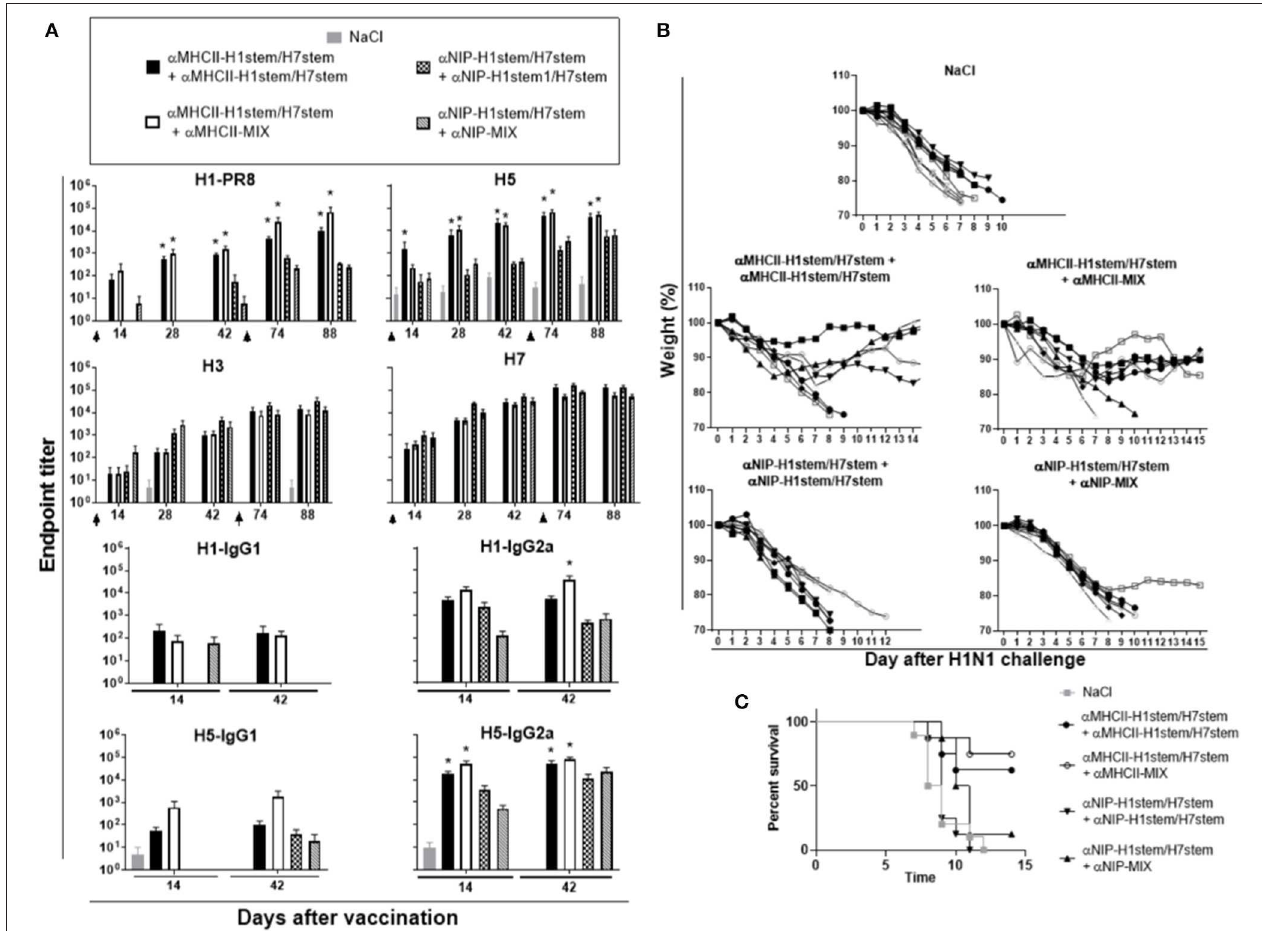
FIGURE 6 | Protection after boost with HA stem domain of MHCII-targeted vaccine mixture. (A) F1 of BALB/c and knock-in 9,114 gH mice ( n = 8 mice/group) were immunized twice, as indicated by arrows, and sera analyzed for development of IgG responses against recombinant HA from PR8 (H1N1), A/Hong Kong/1/1968 (H3N2), A/Hong Kong/483/97 (H5N1), A/Shanghai/1/2013 (H7N9), and A/Hong Kong/1073/99 (H9N2). Values given are mean ± SEM. * p < 0.05 as compared to the corresponding non-targeted control, α NIP-H1stem/H7stem + α NIP-H1stem/H7stem, or α NIP-H1stem/H7stem + α NIP-MIX (two-way ANOVA and Bonferroni post test). (B,C) 10 weeks after the second vaccination, mice were challenged with 2.5 × LD50 of influenza A/PR/8/1934 (H1N1), and monitored for weight (B) and survival (C)